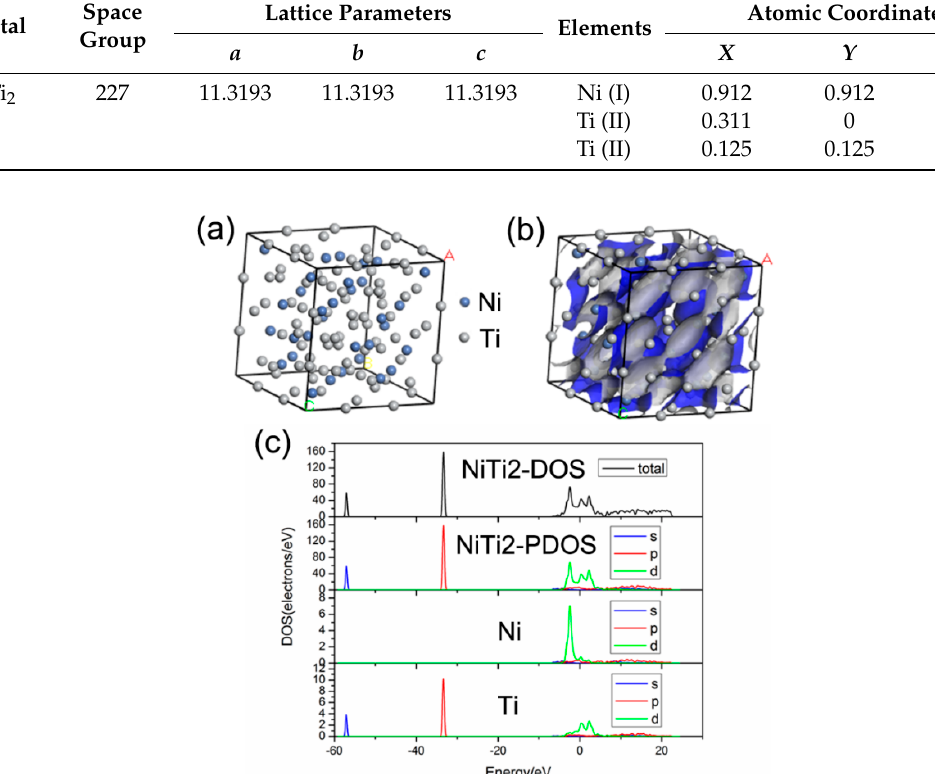
Figure 7. First-principles study of NiTi 2 : ( a ) Unit cell model, ( b ) Electron density map, and ( c ) State density maps.